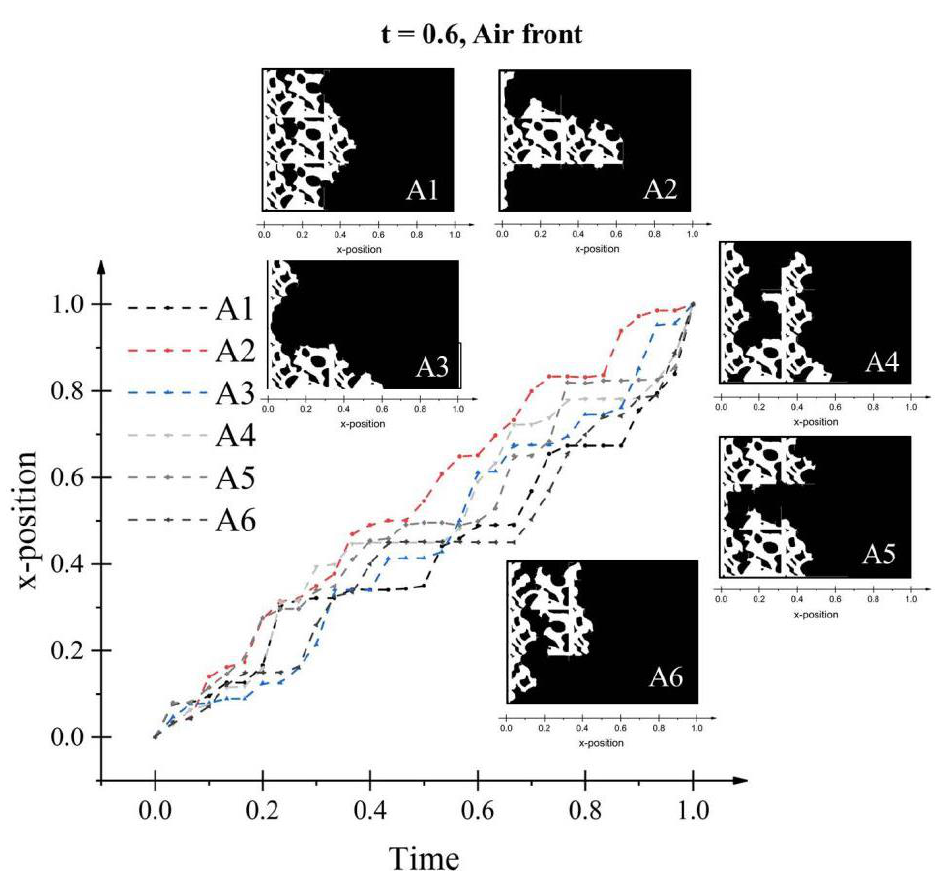
Figure 10. Temporal variation of the gas front position in the horizontal direction: normalized distance of the gas front to the inlet in six cases with various wetting conditions. Note: time and position variables are all dimensionless.